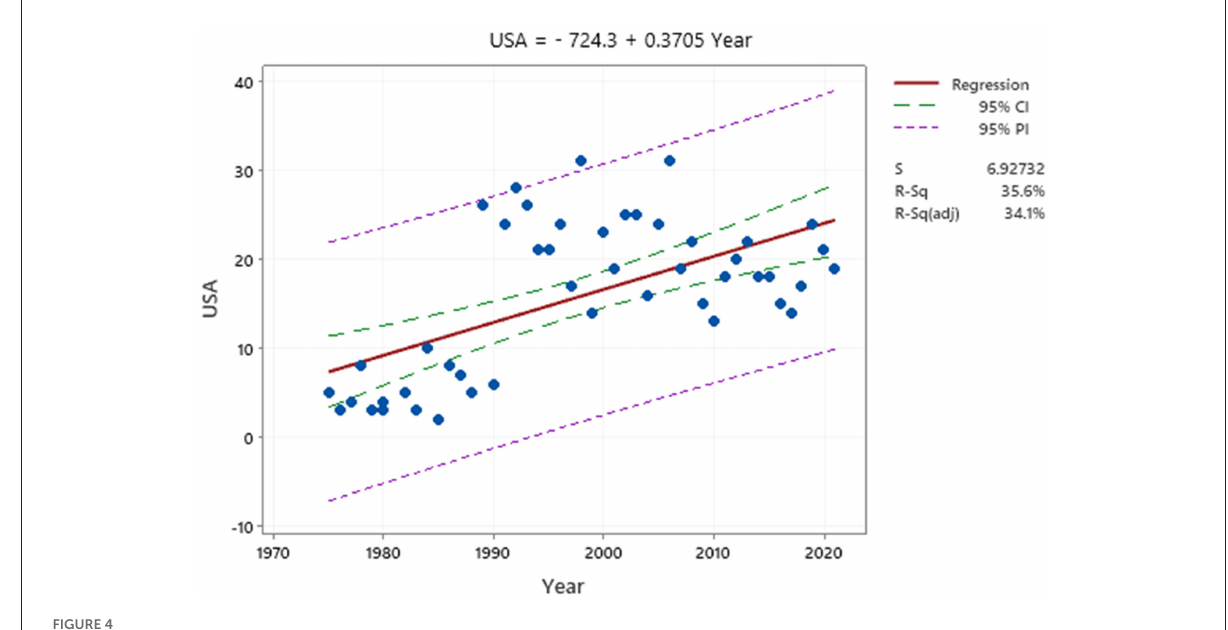
FIGURE4 Article production curve in the United States.